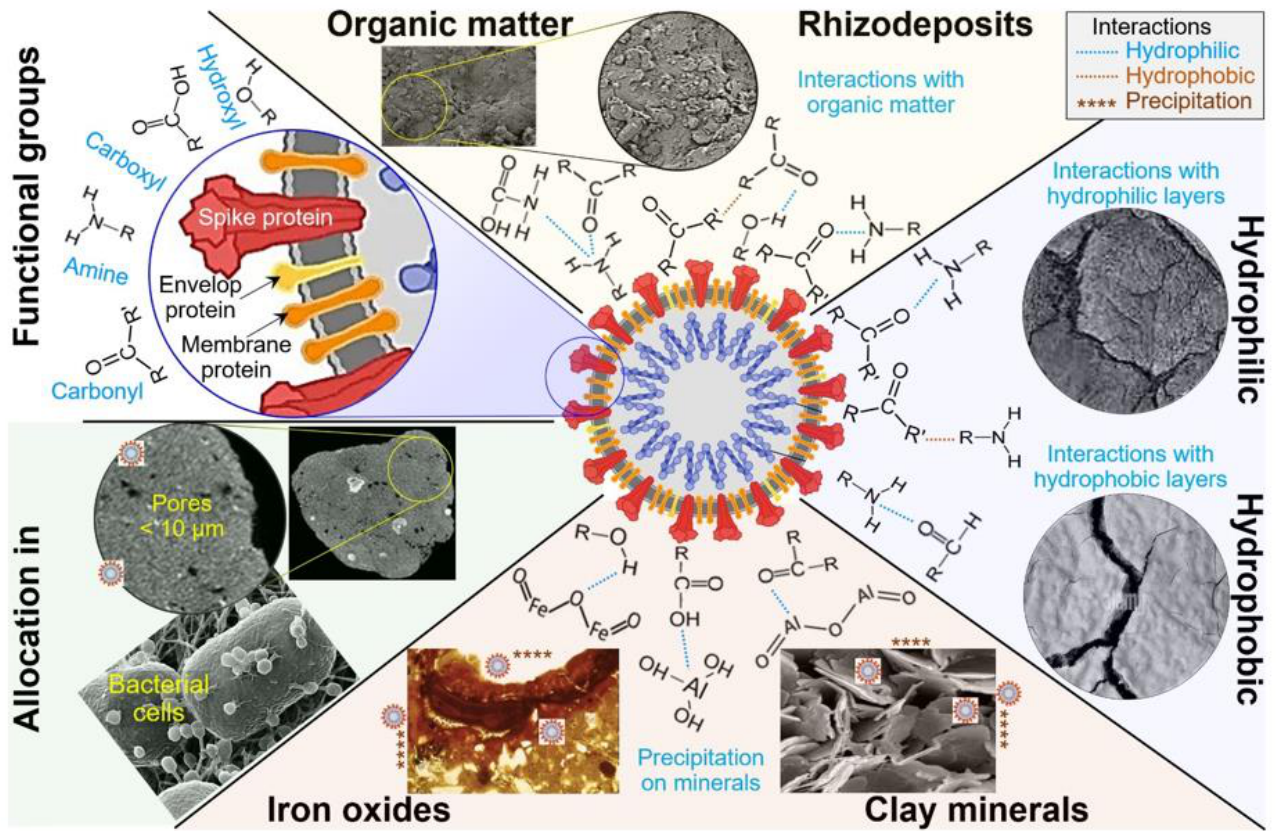
Figure 2. Adsorption of SARS-CoV-2 on soil interfaces (hydrophilic and hydrophobic), organic (organic matter and rhizodeposits) and mineral (clay minerals and iron oxides) constituents, and allocation in pores.